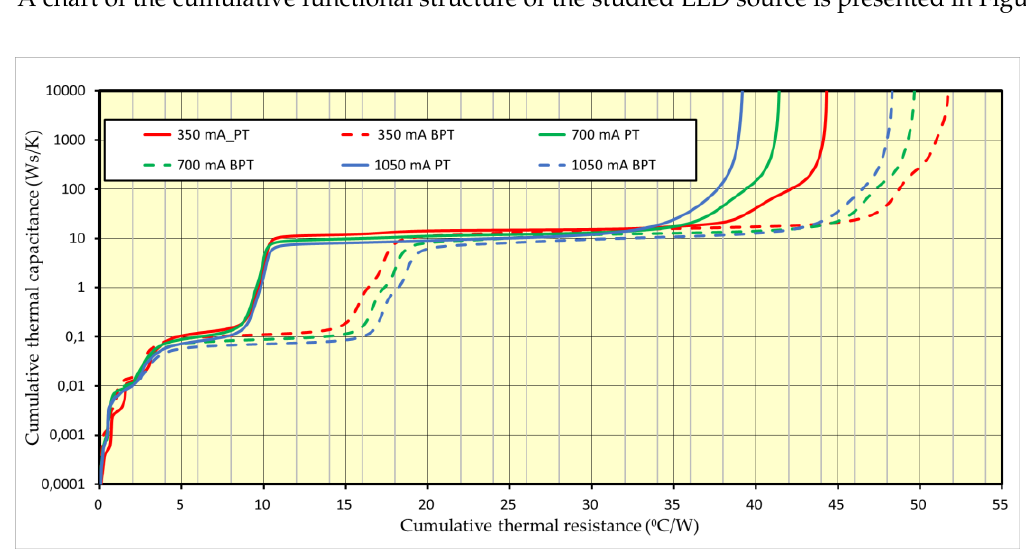
Figure 6. Cumulative thermal structure functions.